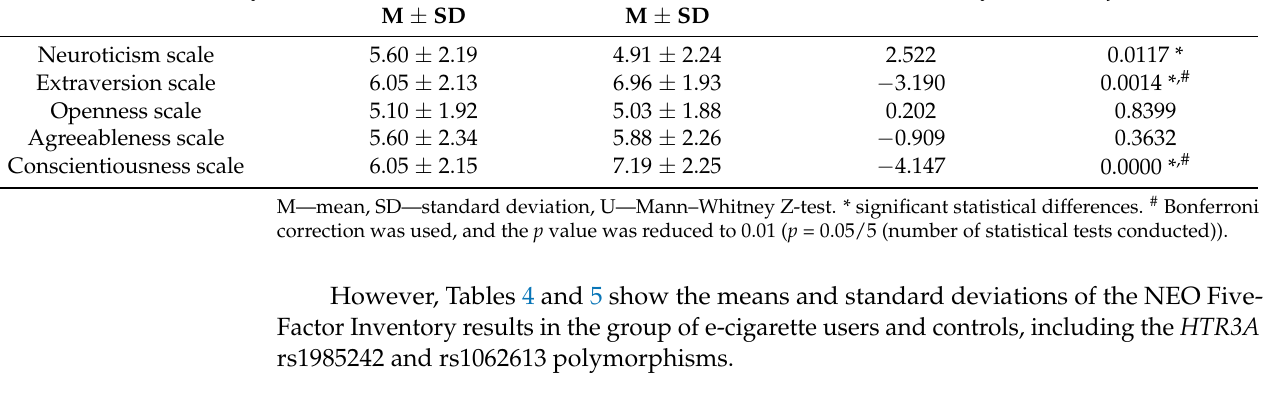
Table 3. Analysis of NEO Five Factor Inventory results in e-cigarette users and controls. Table 4. The results of 2 × 3 factorial ANOVA for e-cigarette users and controls, NEO Five Factor Inventory and HTR3A rs1985242.